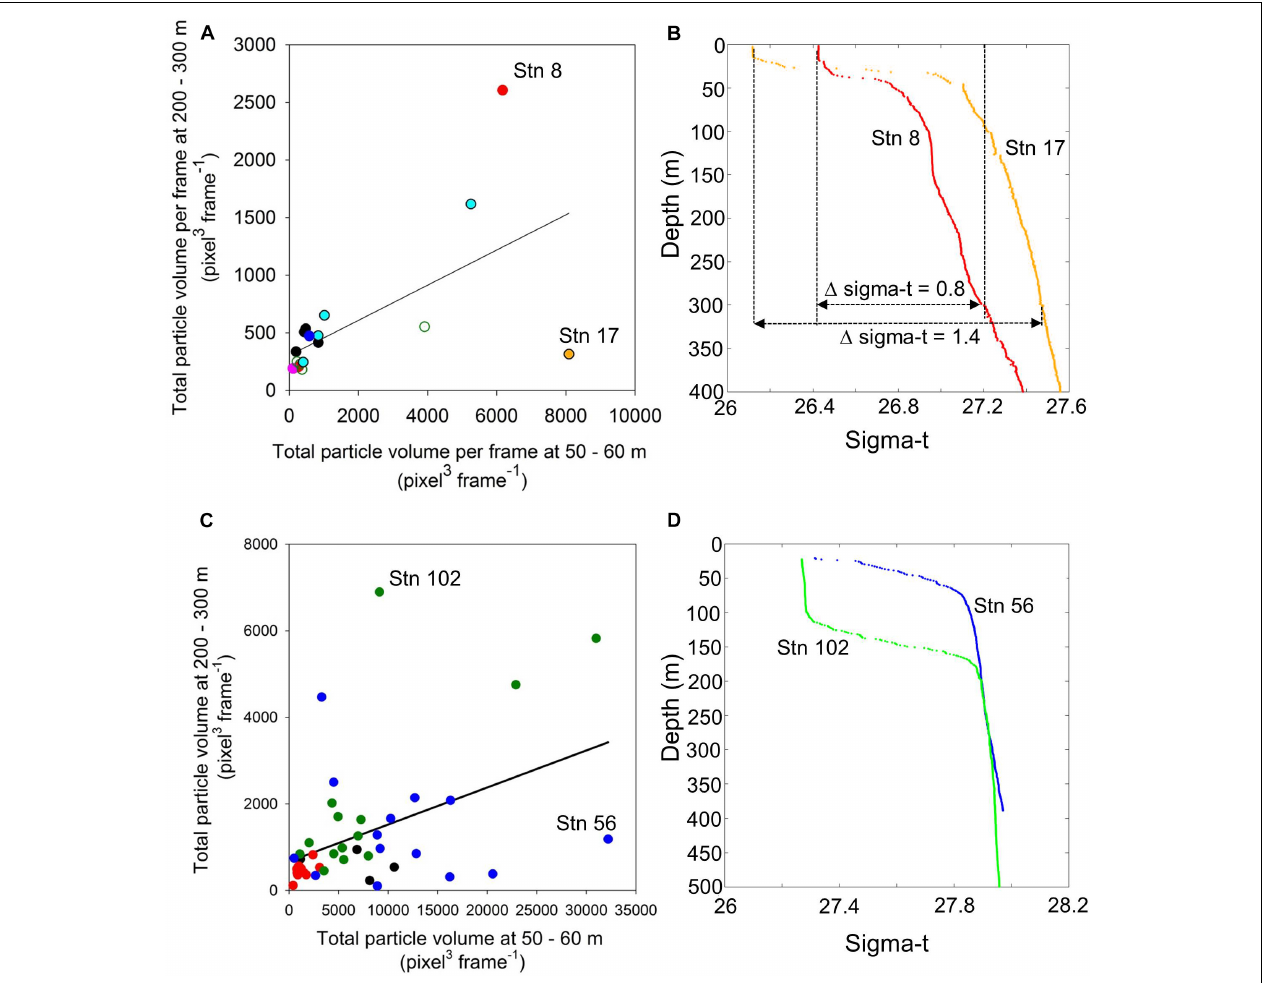
FIGURE 3 | Mean total particle volume at 50–60 versus 200–300 m depth ranges in the North Atlantic (A) and the Ross Sea (C) . The relationships between the particle inventories in the upper and lower water column were significant in both regions albeit at relatively low common variance ( r 2 ). The connectivity between particle volume abundance between upper and lower water column was highly modulated by two factors in the water column physical structure: (1) the absolute density difference ( (cid:49) sigma- t ) between the upper mixed layer and 300 m in the example from the North Atlantic (B) , and the depth of the mixed layer in the Ross Sea (D) . Color codes of data points in the North Atlantic (A) : black, stations east of the Charlie Gibbs Fracture Zone (CGFZ); red, southern trench of the CGFZ; magenta, station 12 west of the CGFZ; green, northern trench of the CGFZ; orange, station 17; cyan, stations 18–21; blue, Norwegian Sea, Arctic. Color codes of data points in the Ross Sea (C) : red, south site; green, Terra Nova Bay; blue, north site; black, transect